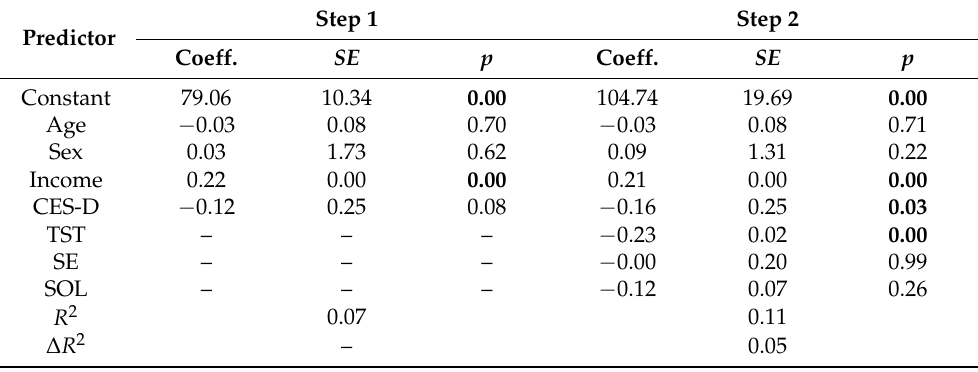
Table 3. Regression analyses of actigraphic indices of sleep in relation to social well-being: N = 213; standardized regression coefficients ( β ); bold font indicates significance; CES-D = Center for Epidemi- ologic Studies Depression Scale (minus sleep item), TST = average total sleep time, SE = average sleep efficiency, SOL = average sleep-onset